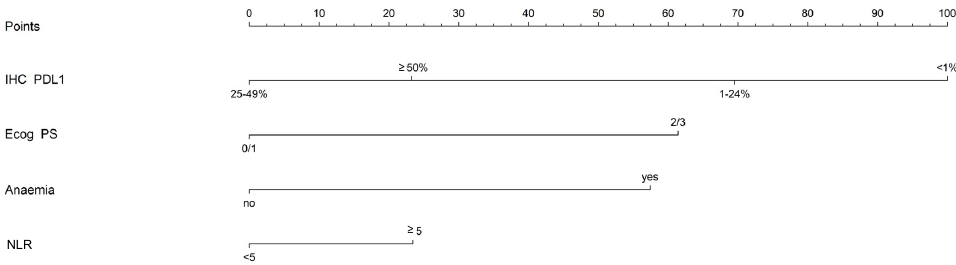
events during the entire follow-up period) the AUROC in predicting 6- and 12-month OS